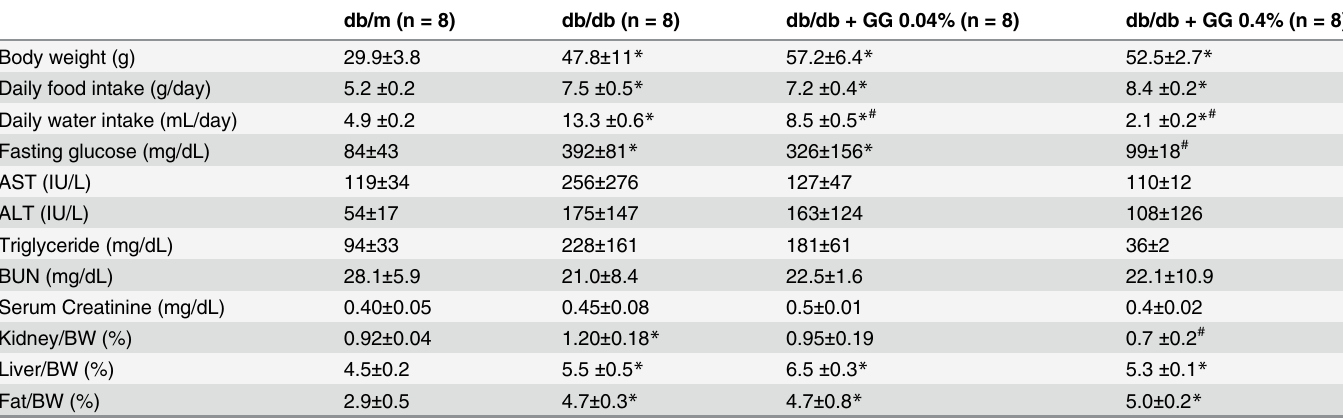
Table 1. Physical and biochemical characteristics of study groups.